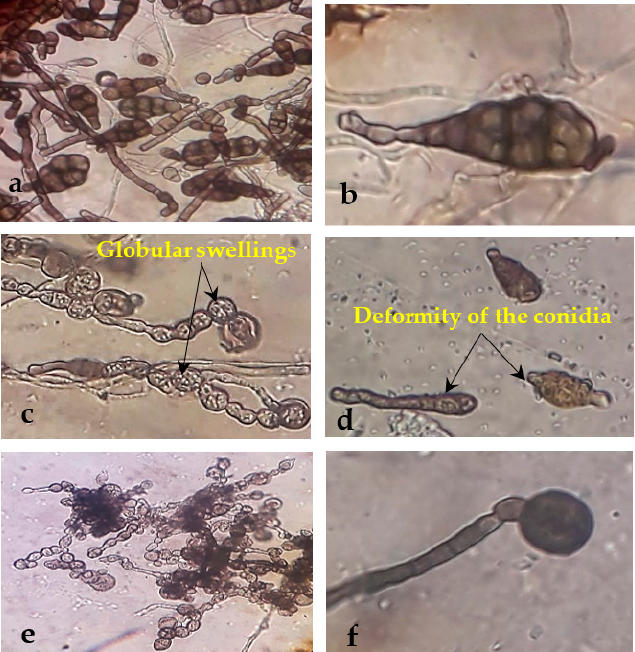
Figure 5. Morphological abnormalities in the mycelia of Alternaria sp. upon interaction with en- dophytic bacteria. Images ( a , b ) show the untreated (control) Alternaria sp. mycelia and spores. ( c , d ) show the swelling and deformity of Alternaria sp. mycelia and spores treated with B. velezensis . ( e , f ) were representatives of the segmentation and deformation of Alternaria sp. mycelia and spores treated with B. amyloliquefaciens.